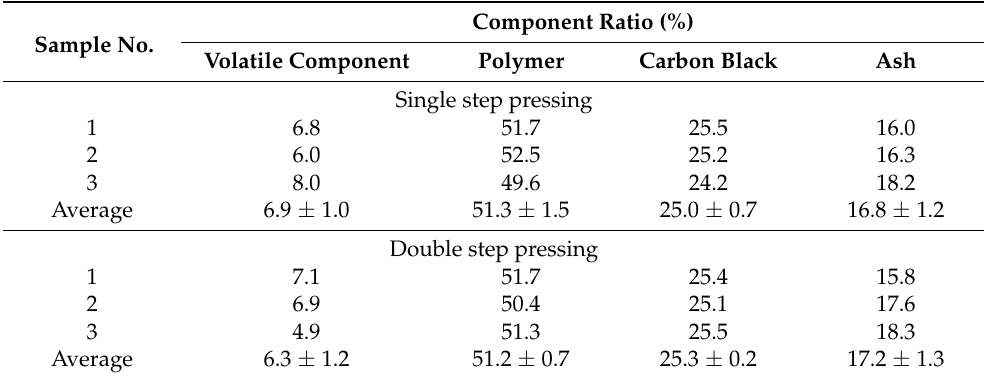
Table 2. TGA results of the model TRWPs prepared by the TWPs without treatment. Component Ratio (%) Sample No. Volatile Component Polymer Carbon Black